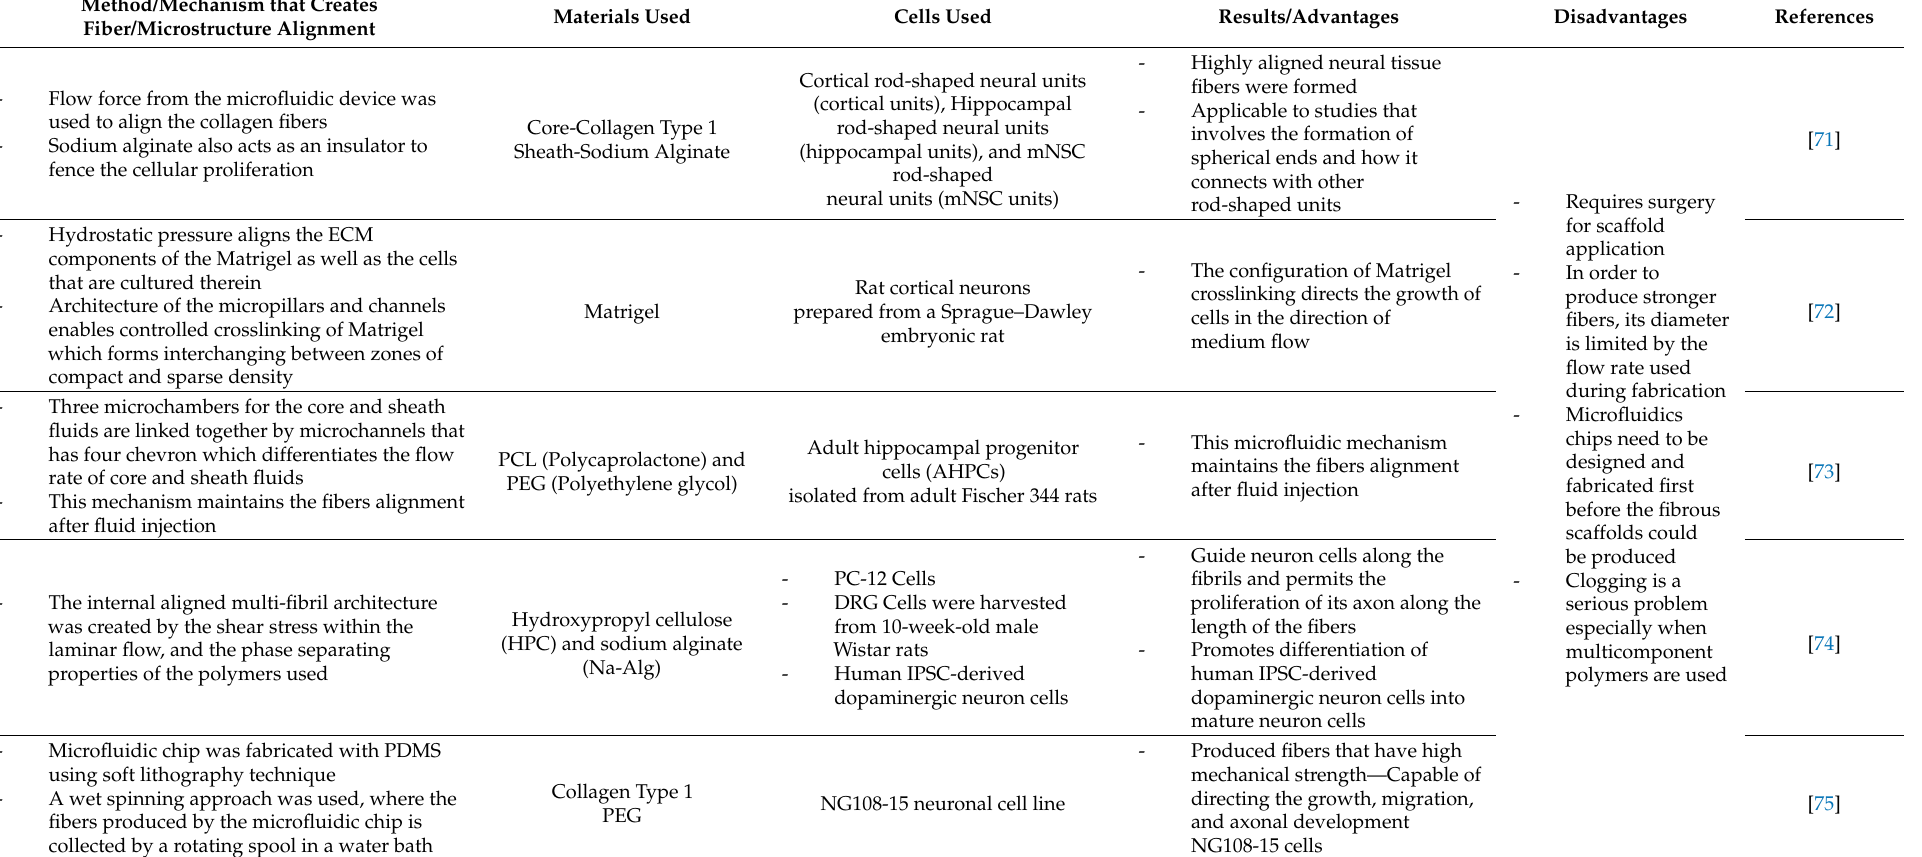
Table 2. Summary of modified microfluidic fabrication methods to produce scaffolds for